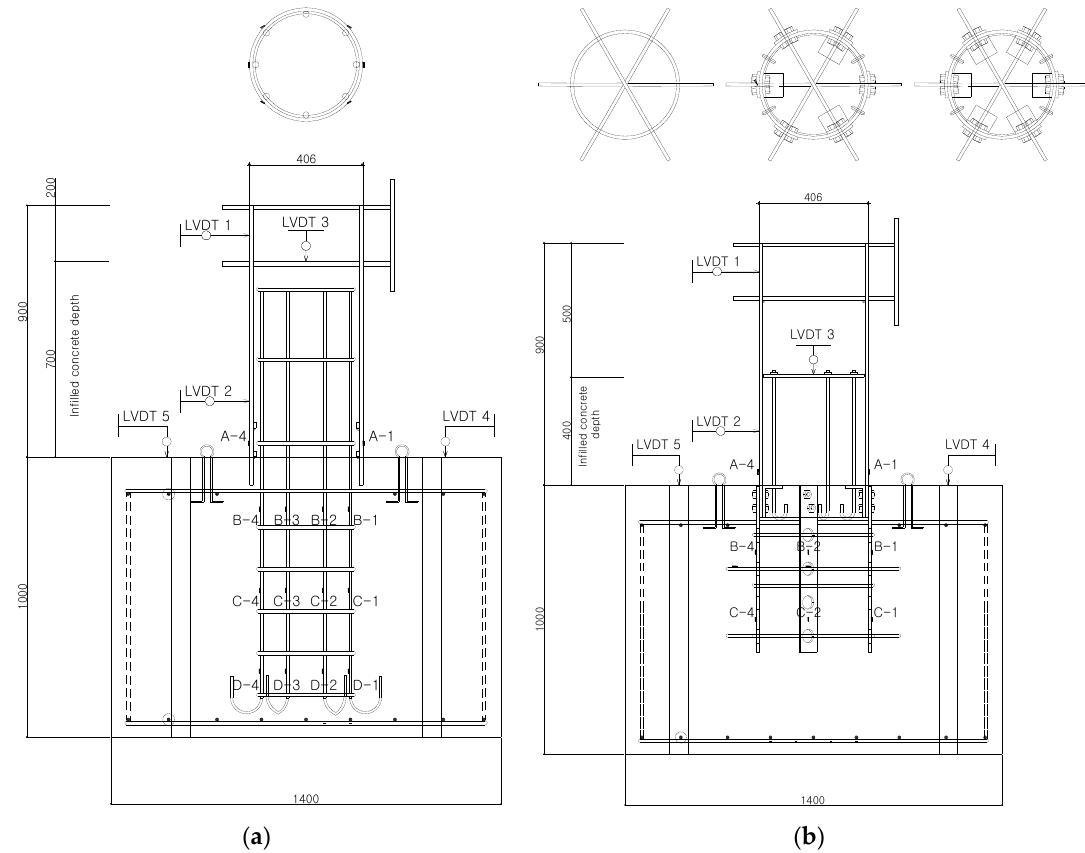
Figure 3. Details of test specimens. ( a ) Specimen strengthened with conventional steel rebars. ( b ) Specimen strengthened with perfobond shear connectors. (unit: mm).